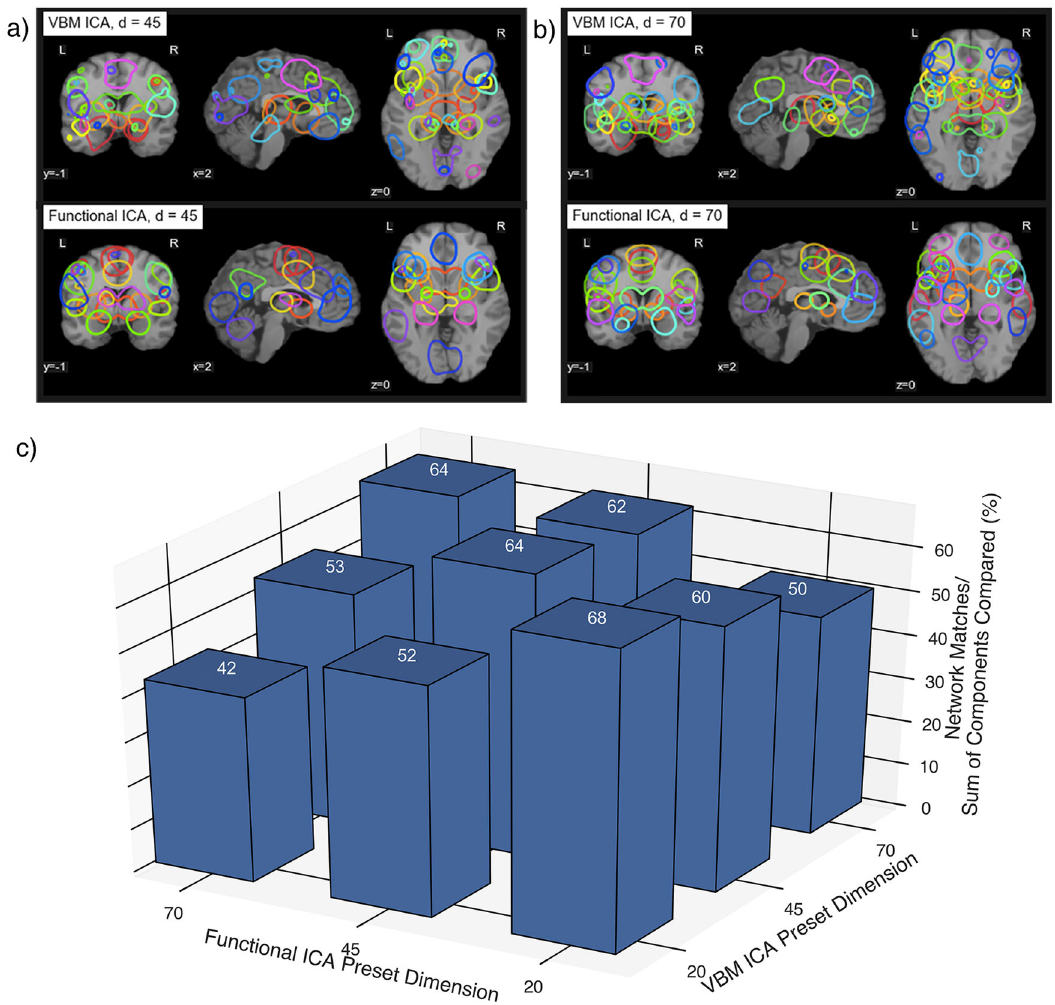
Fig. 2 Higher model order comparisons. Components that matched at higher dimensionalities of a 45 and b 70. c Percentage of network matches applying the same correlation threshold across n = 9 separate combinations of dimensionalities (20/45/70). Source data are provided in Supplementary Data